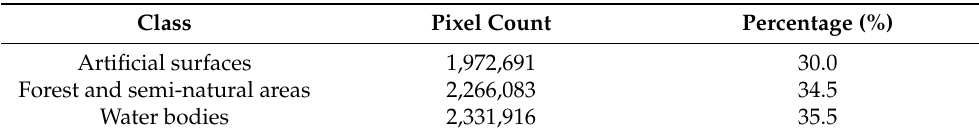
Table 1. Training data class distribution for Sentinel dataset.